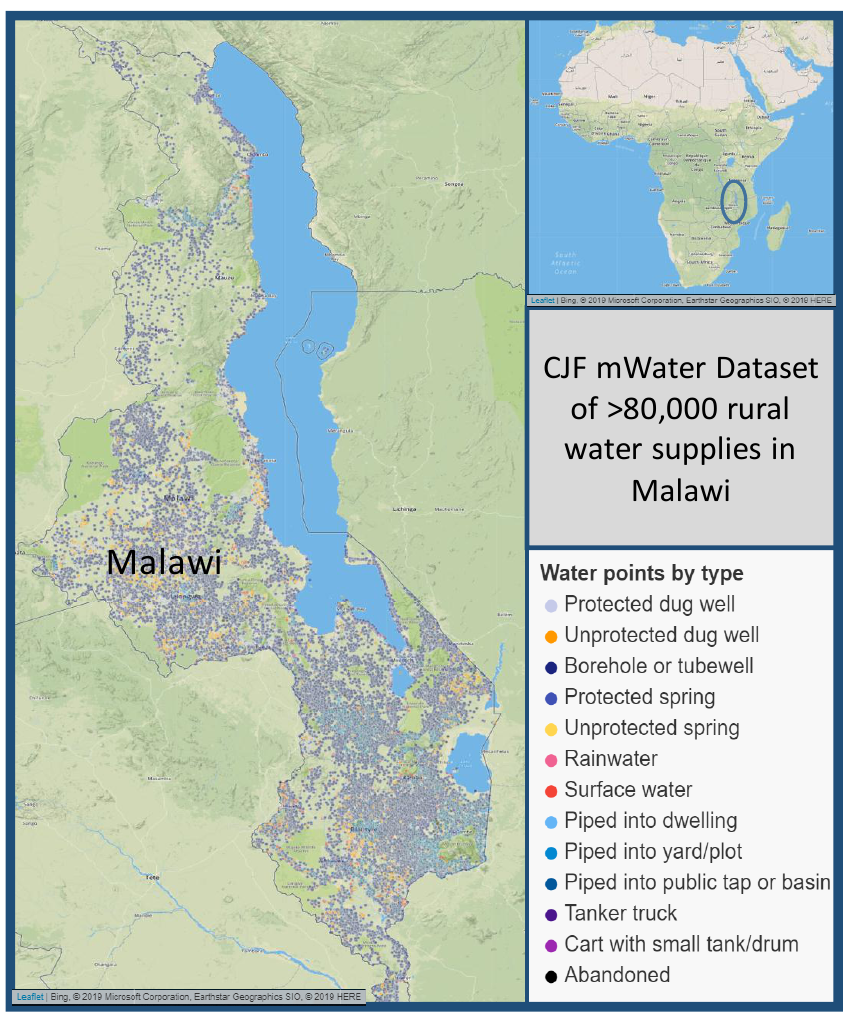
Figure 1. Map of Malawi with locations of currently known rural water supply assets (as of 1 March 2019).